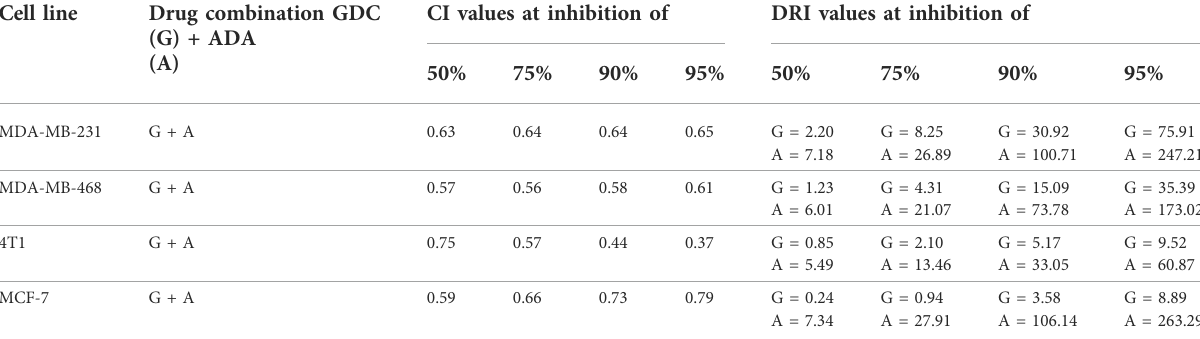
TABLE 2 Summary of CompuSyn simulated CI and DRI values for GDC-0941 and adapalene combination in breast cancer cell lines at 50, 75, 90, and 95% growth inhibition.